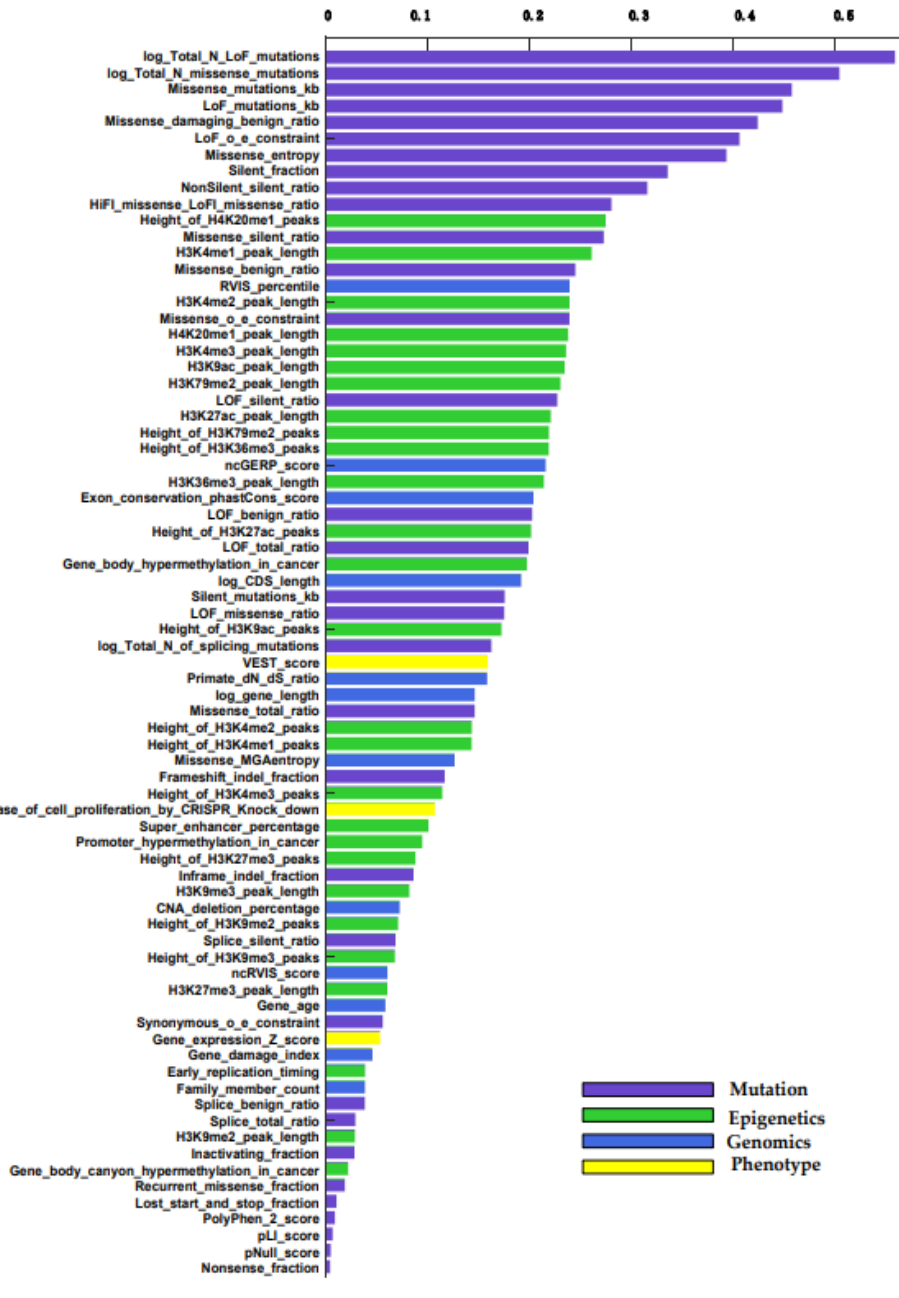
Figure 2. KL divergence of each feature is based on CGC genes and non-CGC genes.